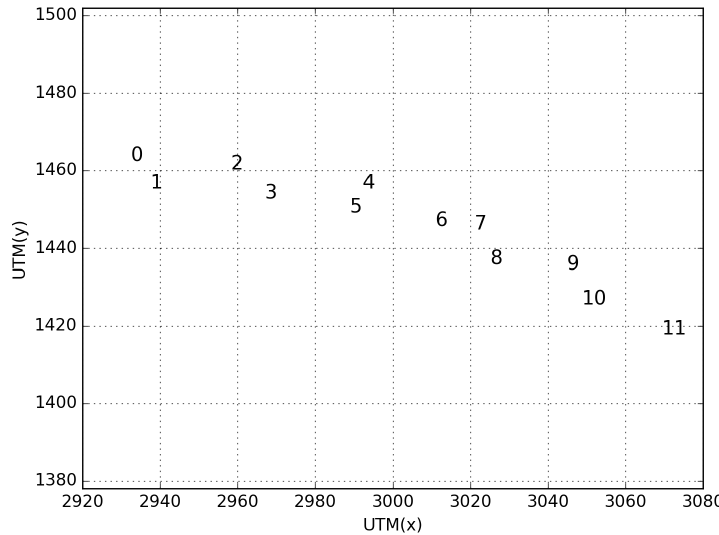
Figure 5. A typical disposition of vehicles inside a